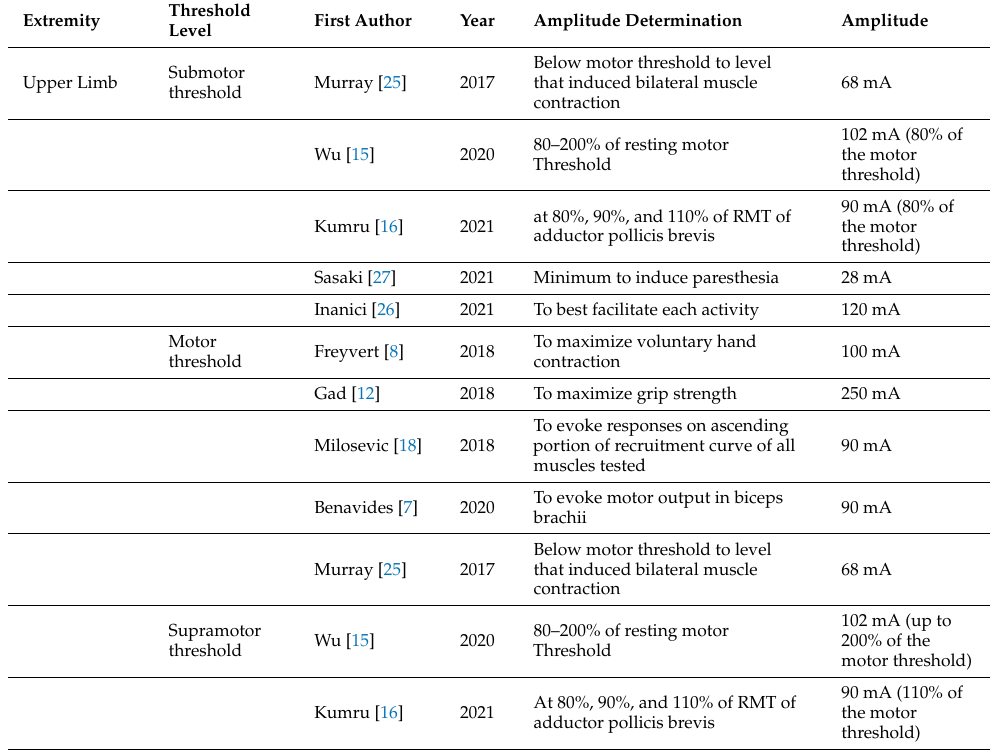
Table 2. Stimulation amplitude for TSS applications with variable motor